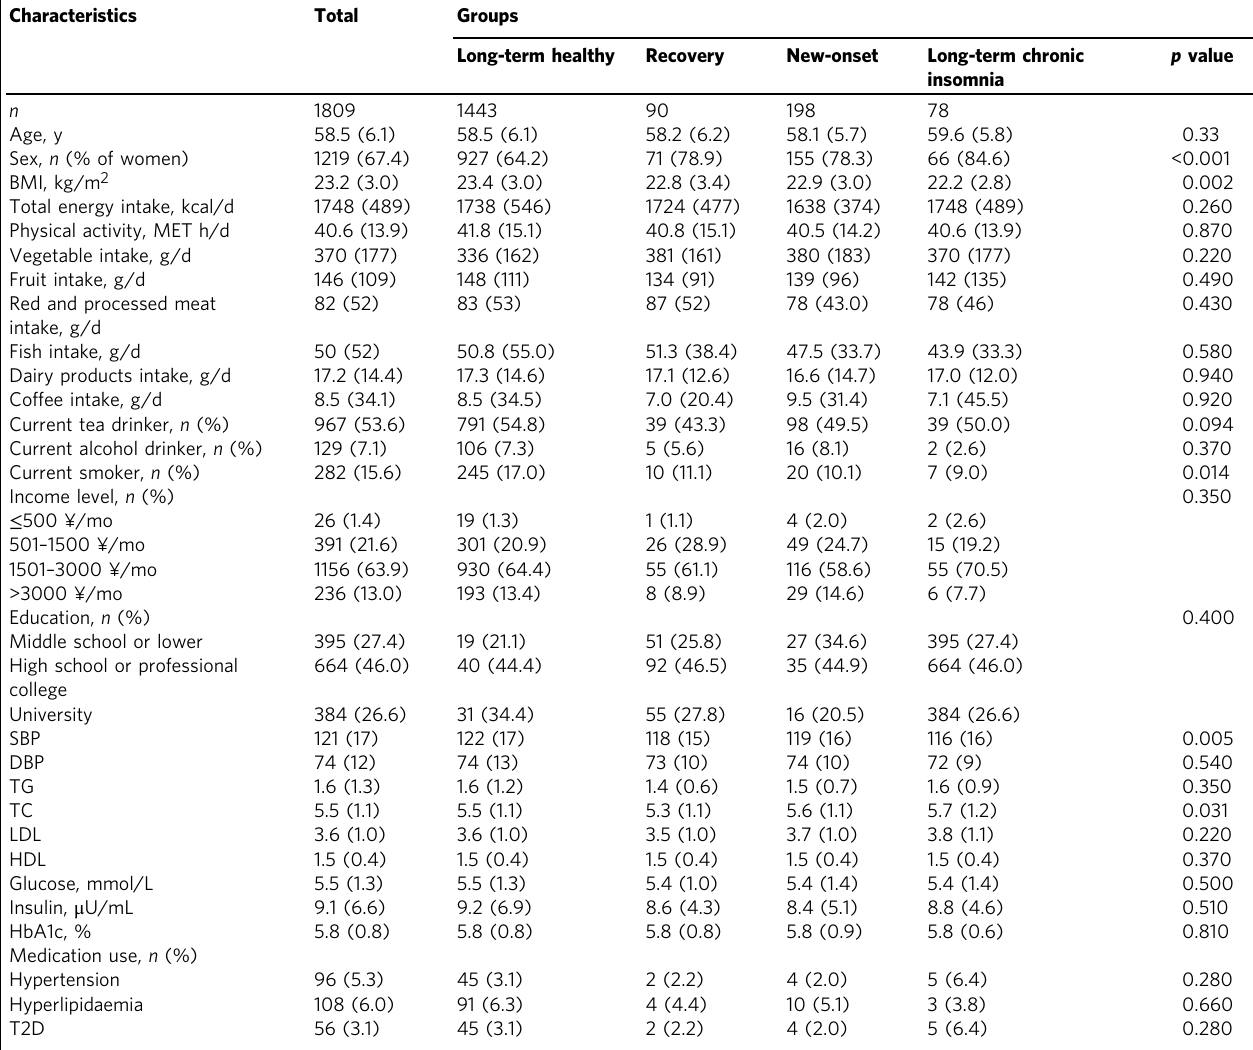
Table 1 Characteristics of the study participants in the Guangzhou Nutrition and Health Study a .